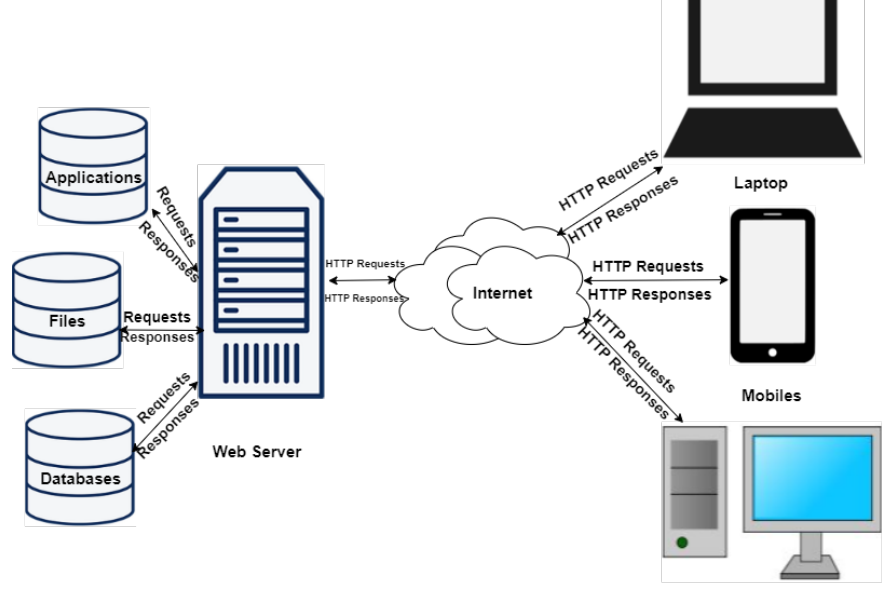
Figure 13. A Simple Web Server